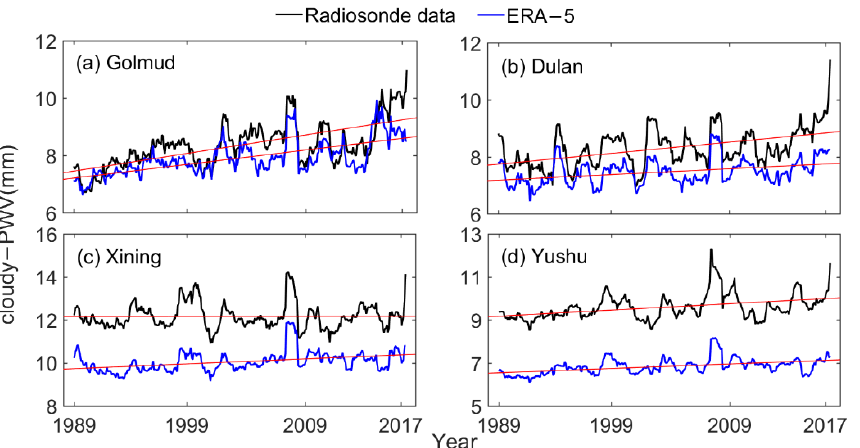
Figure 11. Variation trend of the 12-month moving average of monthly PWV under cloudy sky con- dition at different stations. ( a ) Golmud station ( b ) Dulan station ( c ) Xining station ( d ) Yushu station